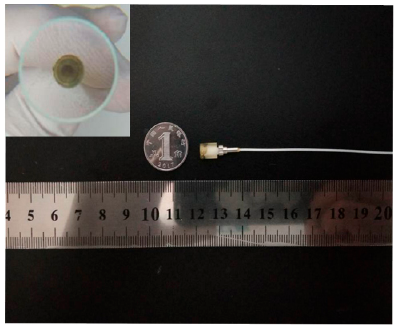
Figure 8. Actual size and shape of this sensing probe.